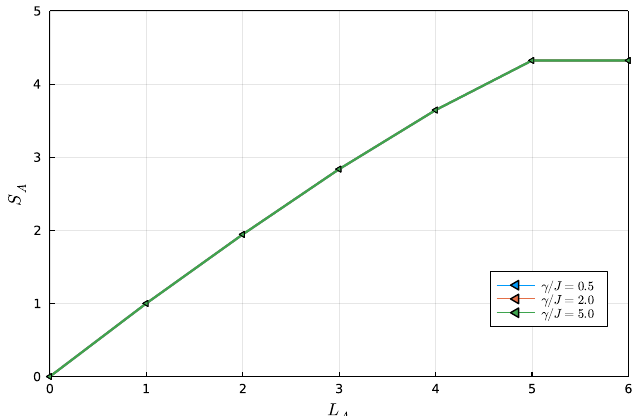
Figure 9: Saturation value of entanglement entropy S ferent subsystem size L . Different curves have different γ in the unit of J . Here, A = 6, N = 3, U / J = 1. The density matrix is evolved by the single-copy master N s b equation the Eq. ( 8 )